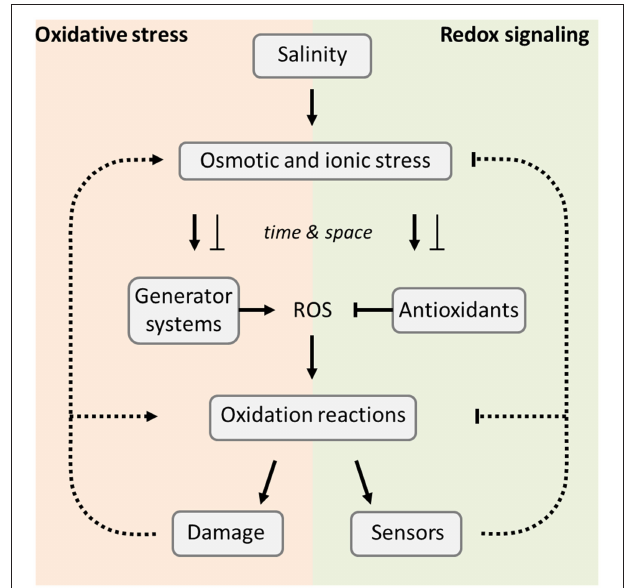
FIGURE 1 | Overview of salinity-induced stress effects. The primary stress effects are osmotic and ionic imbalances which affect the ROS generator and antioxidant systems. This effect may be positive or negative as indicated and discussed. Their relative activities determine the ROS levels, as well as the subsequent redox reactions which are used in signaling (right hand side) or, if excessive, cause oxidative damage which enhances the stress effects (left hand side)